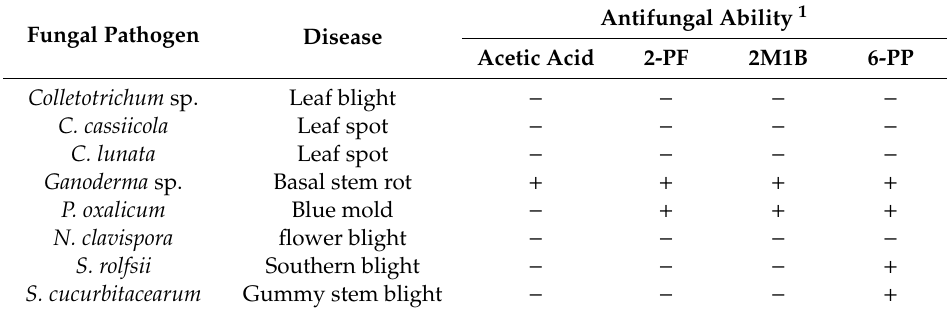
Table 4. Antifungal activities of commercial volatile compounds against fungal pathogens.